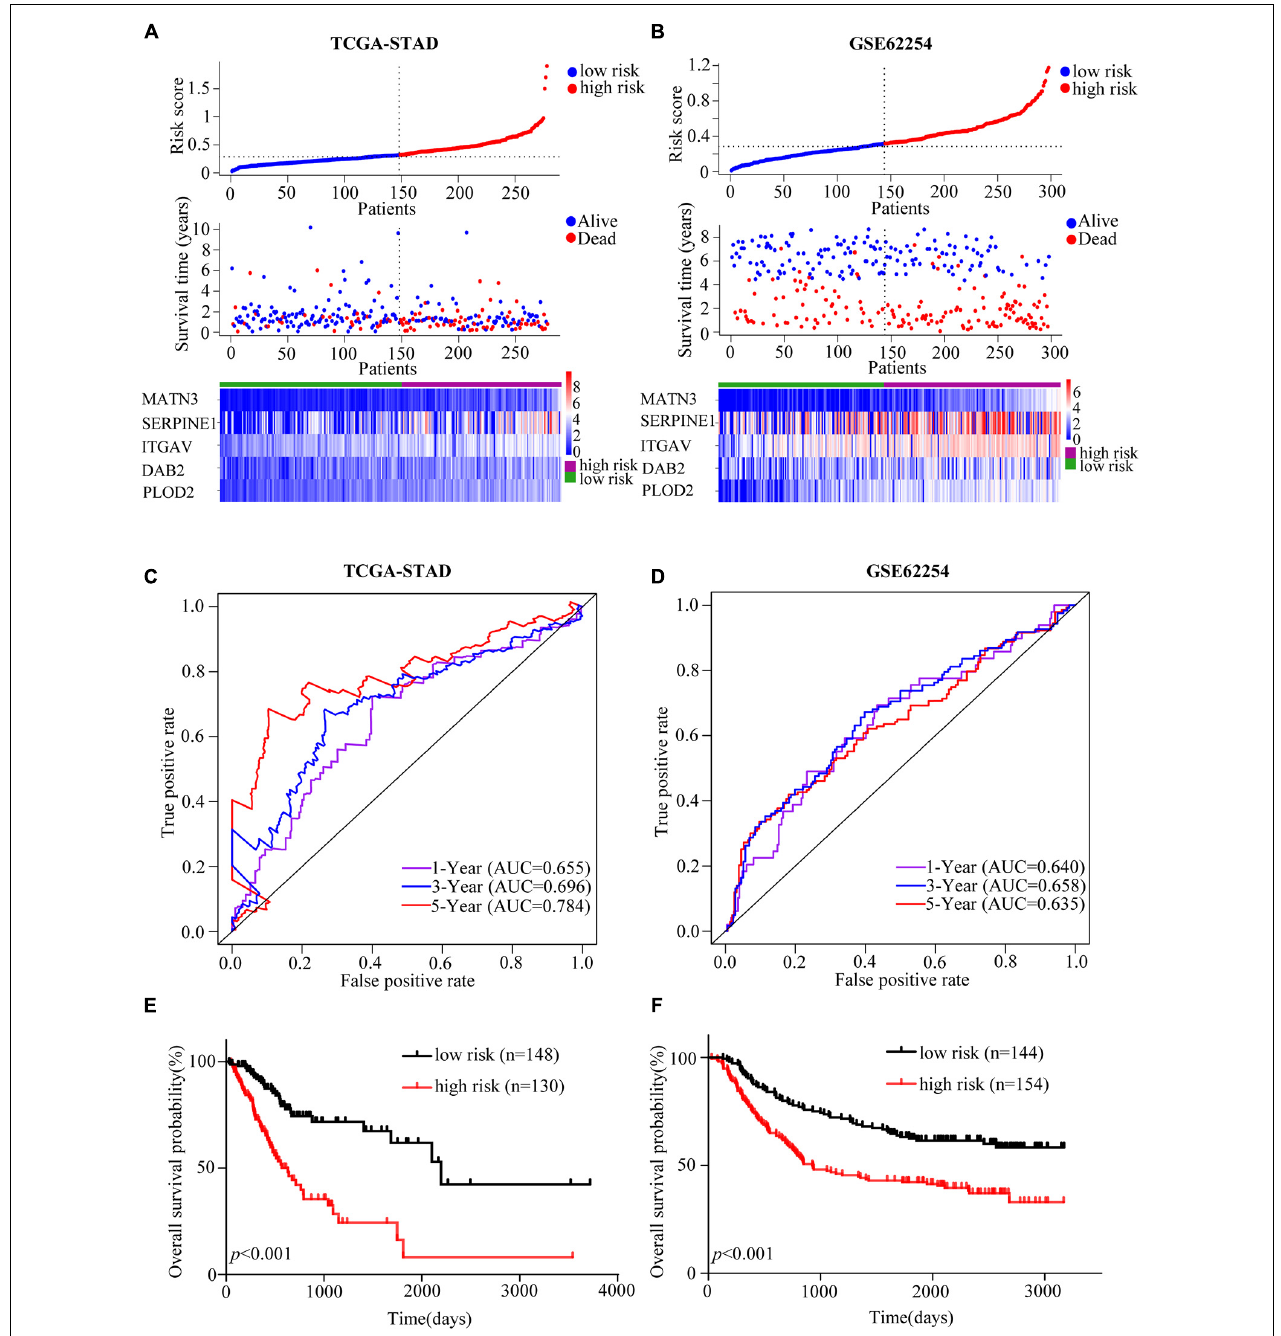
FIGURE 2 | Assessment and validation of the EMT-related gene signature in GC. (A,B) Risk score analyses including risk score distributions, survival statuses and heatmaps of the EMT-related genes expression in the TCGA-STAD (A) and GSE62254 (B) cohorts. (C,D) Time-dependent ROC curves of the EMT-related gene signature in the TCGA-STAD (C) and GSE62254 (D) cohorts. (E,F) Kaplan-Meier estimates of OS based on the EMT-related gene signature in the TCGA-STAD (E) and GSE62254 (F) cohorts. The TCGA-STAD cohort was used as the training set while the cohort GSE62254 was used for external validation.